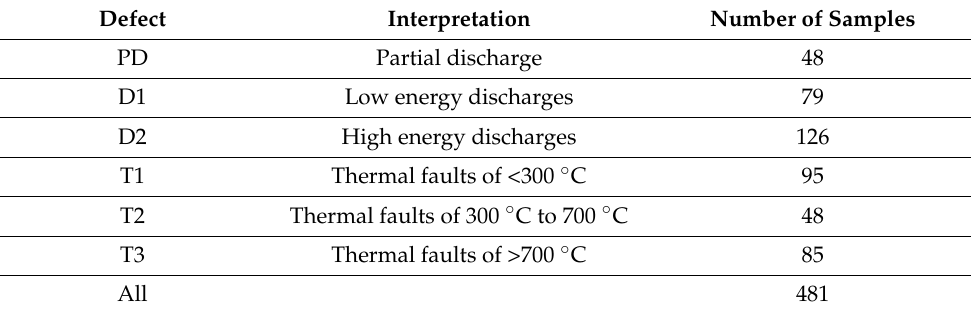
Table 1. Database distribution.